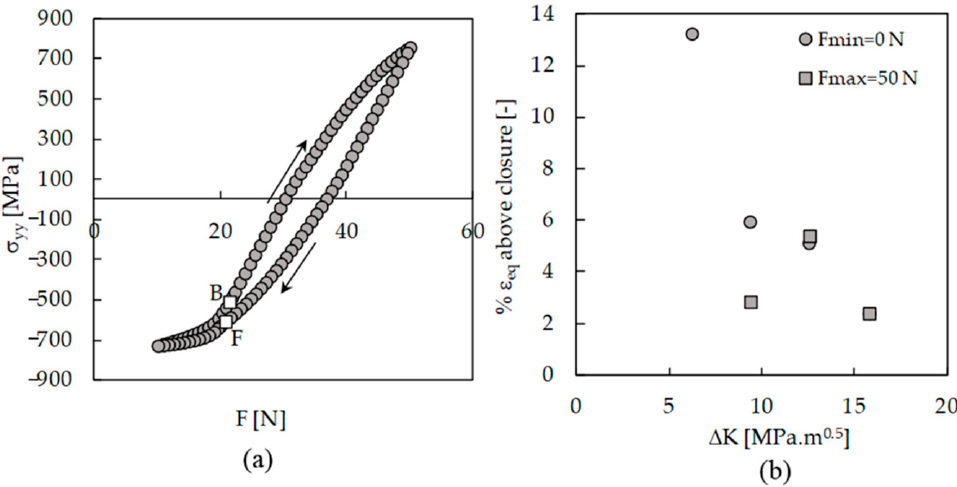
Figure 9. ( a ) Crack tip stress versus remote load ( F max = 50 N; F min = 10 N). ( b ) Percentage of deformation below closure.